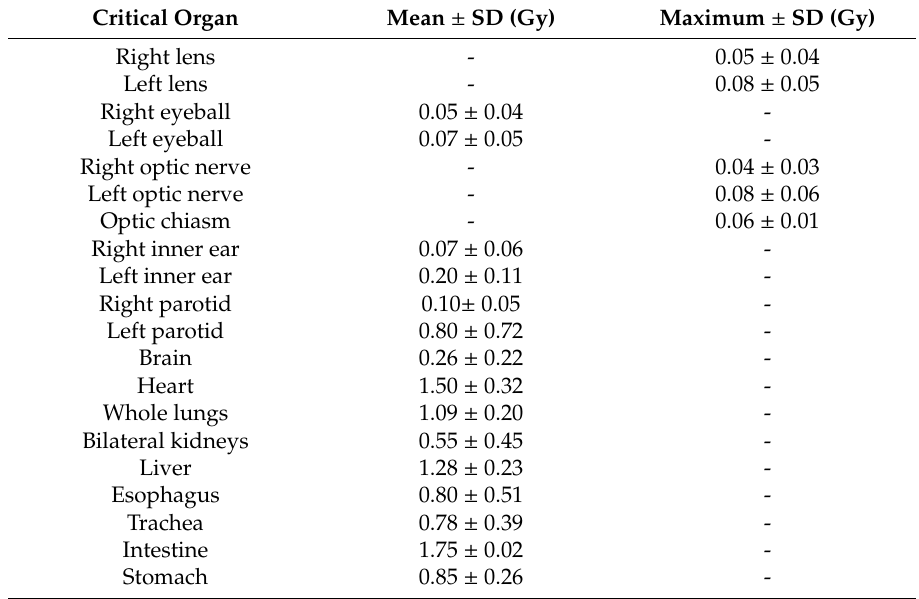
Figure 3. One patient had a keloid on the left ear (up picture in the figure). He was treated with helical tomography within 24 h after keloid excision with 13.5 Gy in 3 fractions. ( A ) Transverse view. ( B ) Sagittal view. Table 2. Calculated doses to organs at risk and the Paddick conformity index (PCI) and uniformity index (UI) for patients with keloids treated with helical